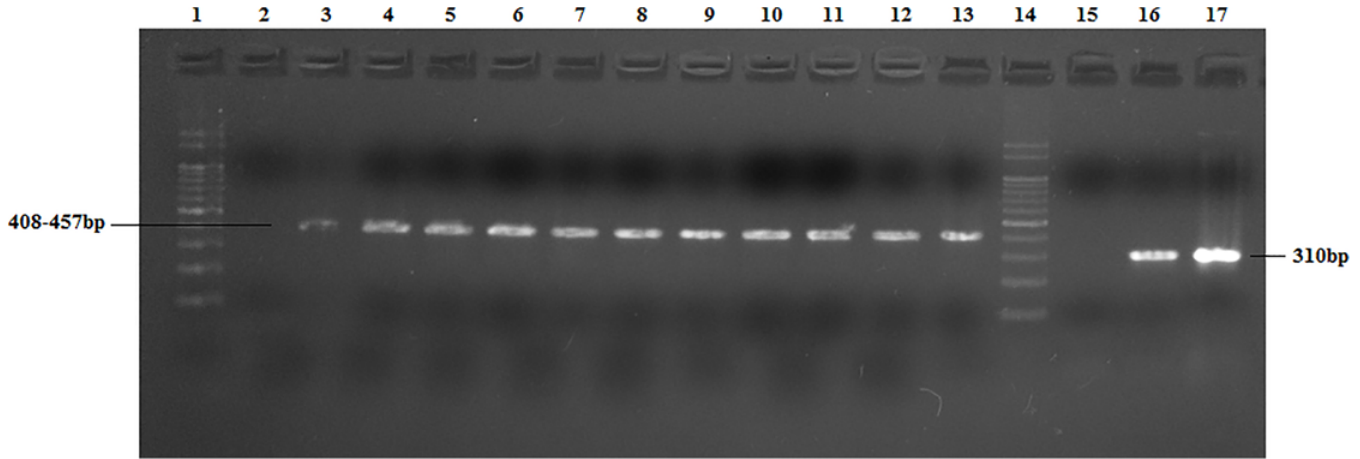
Fig 2. Amplicon bands revealed by genus and species specific primers against Naegleria isolates for representative samples. Genus Naegleria specific amplification (Lane 1 – 13), Lane 1 Ladder 100bp, Lane 2 Negative control, Lane 3 Positive control, Lane 4 – 13 Positive samples. N . fowleri